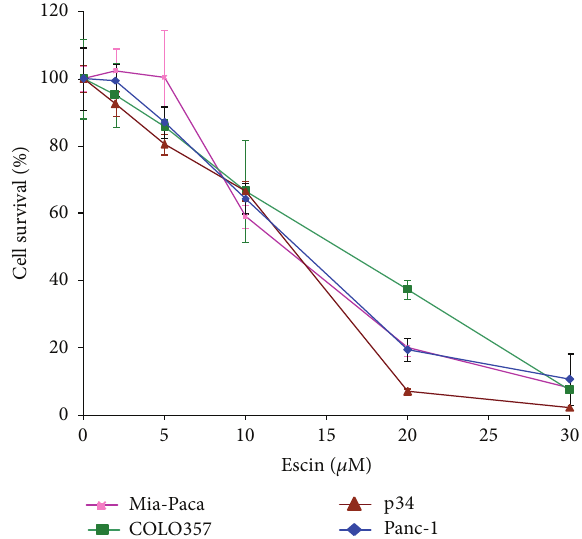
Figure 1: Effect of Escin on survival of cultured pancreatic cancer cells. Panc-1, MIA-Paca, COLO 357, and p34 cells were plated in 96- well plates and treated with Escin (2–30 𝜇 M) for 3 days. Cell survival was assessed by XTT assay in 3 independent experiments conducted in